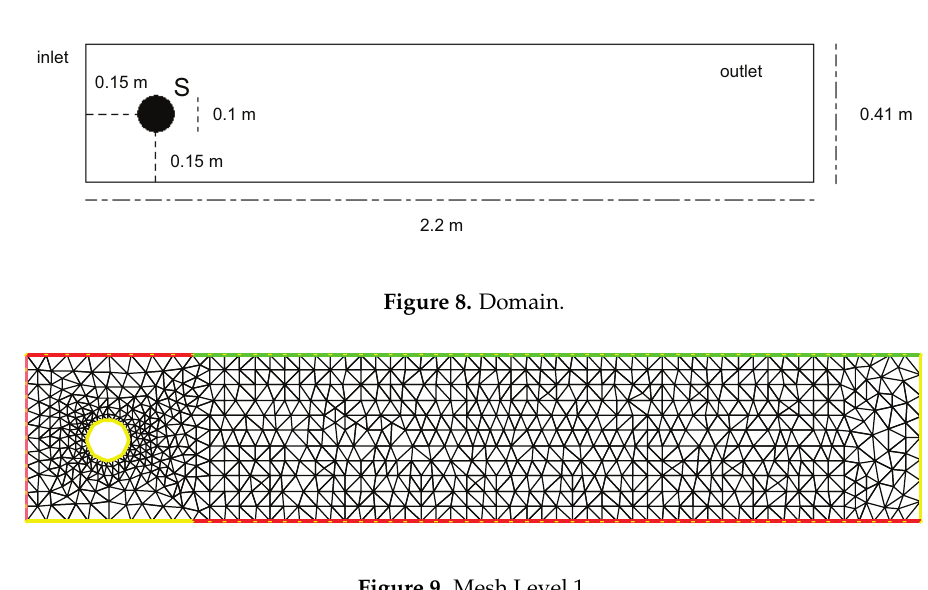
Figure 9. Mesh Level